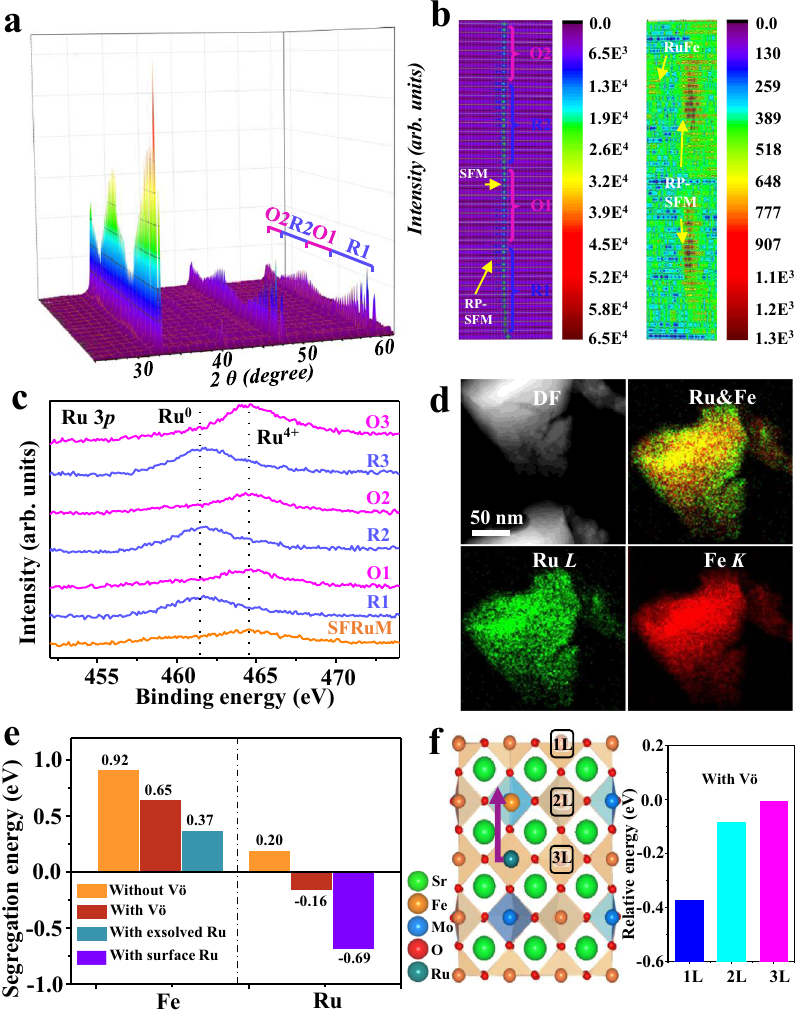
Fig. 3 Characterization and DFT results of SFRuM. a In situ XRD patterns of as-prepared SFRuM upon switching between reducing and oxidizing atmosphere at 800 °C. b Depth pro fi le of XRD patterns at 31 – 33° and 43 – 45° of ( a ). c Ru 3 p XPS spectra of SFRuM after redox manipulations. d STEM-EDS elemental maps of SFRuM O3. e Comparison of segregation and co-segregation energies with Fe and the doped Ru. f Schematic of exsolution process with relative energy of the slab as a function of Ru positions. 1L denotes the surface layer and 3L corresponds the inner Figs. 20, 21), which con fi rms the self-enrichment function of SFRuM after repeated redox manipulations.